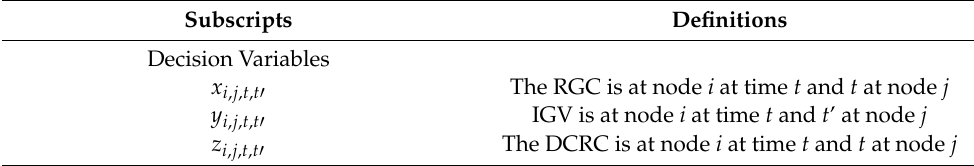
Table 3. Decision variables for the model